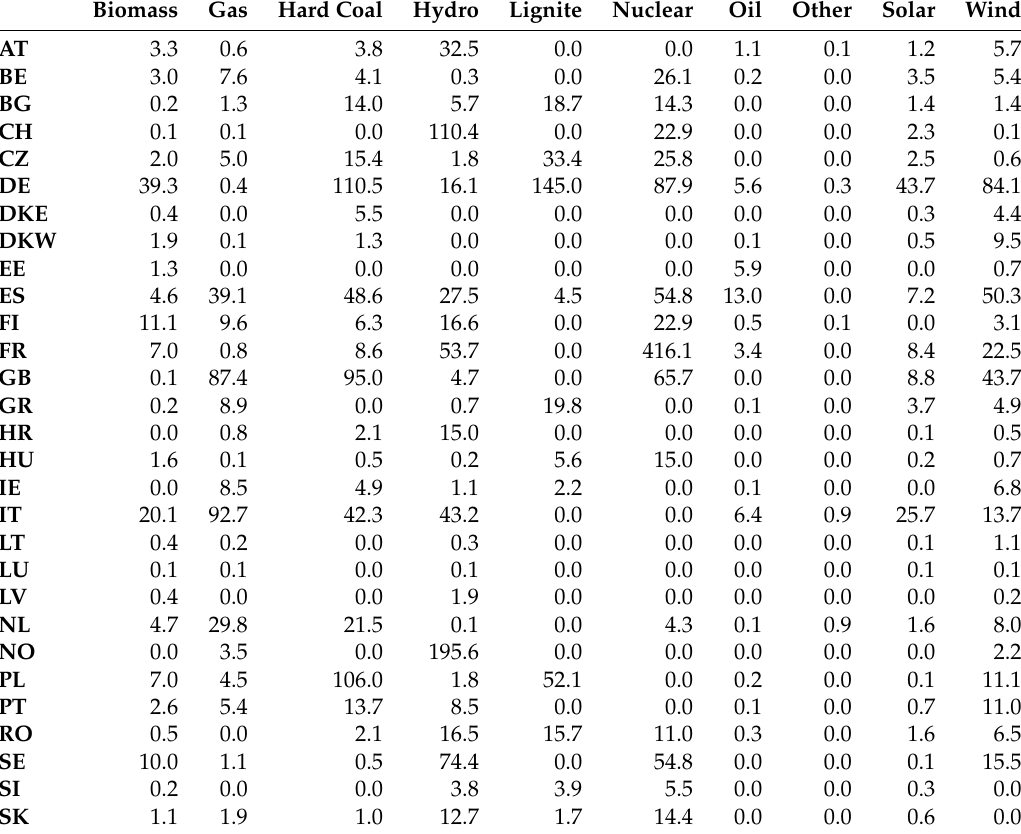
Table A3. Electricity generation